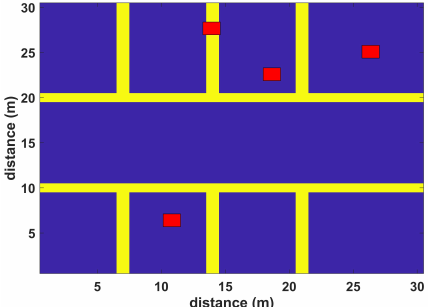
Figure 4. Floor map with 30 m by 30 m dimensions.